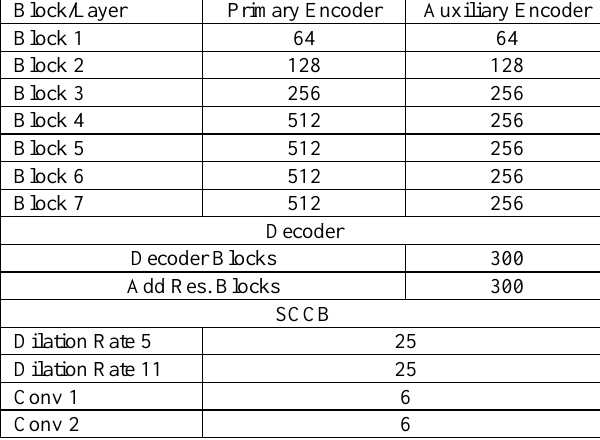
Table 1. Number of filters in convolution layers in each